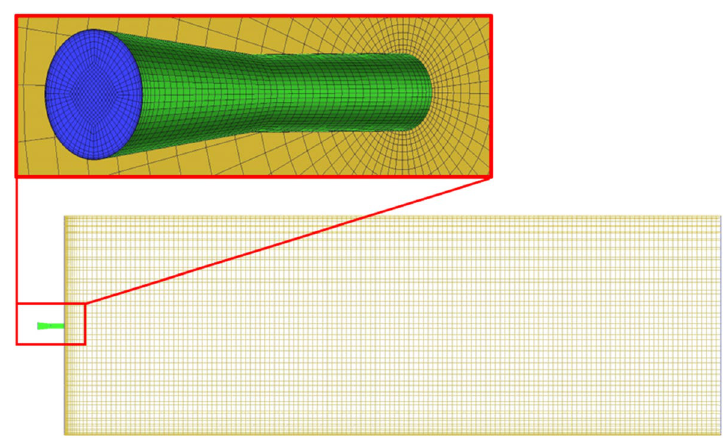
Fig. 5 Single nozzle flow field model meshing. a Nozzle structure. b Extraction chamber structure. c nozzle mesh. d Extraction chamber mesh. e Overall